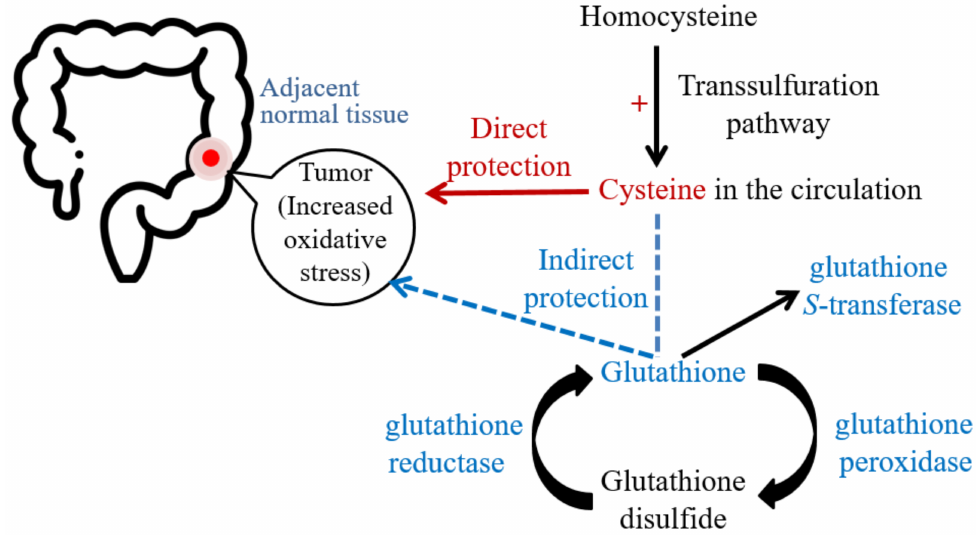
Figure 1. The possible effects of cysteine on oxidative stress and glutathione-related antioxidant capacities during the existence of colorectal